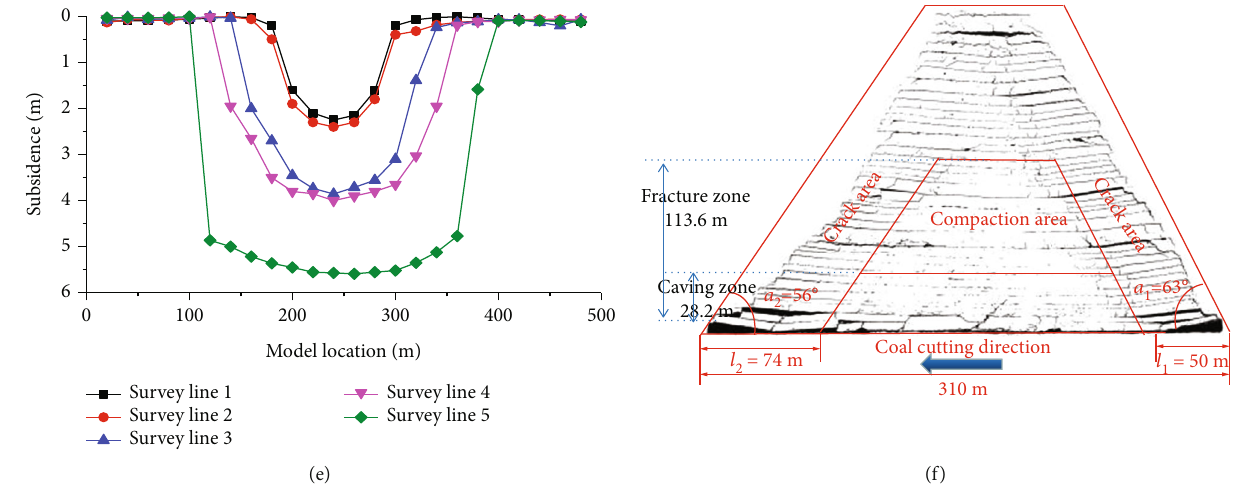
Figure 4: Migration and fracture development of overlying strata during coal seam